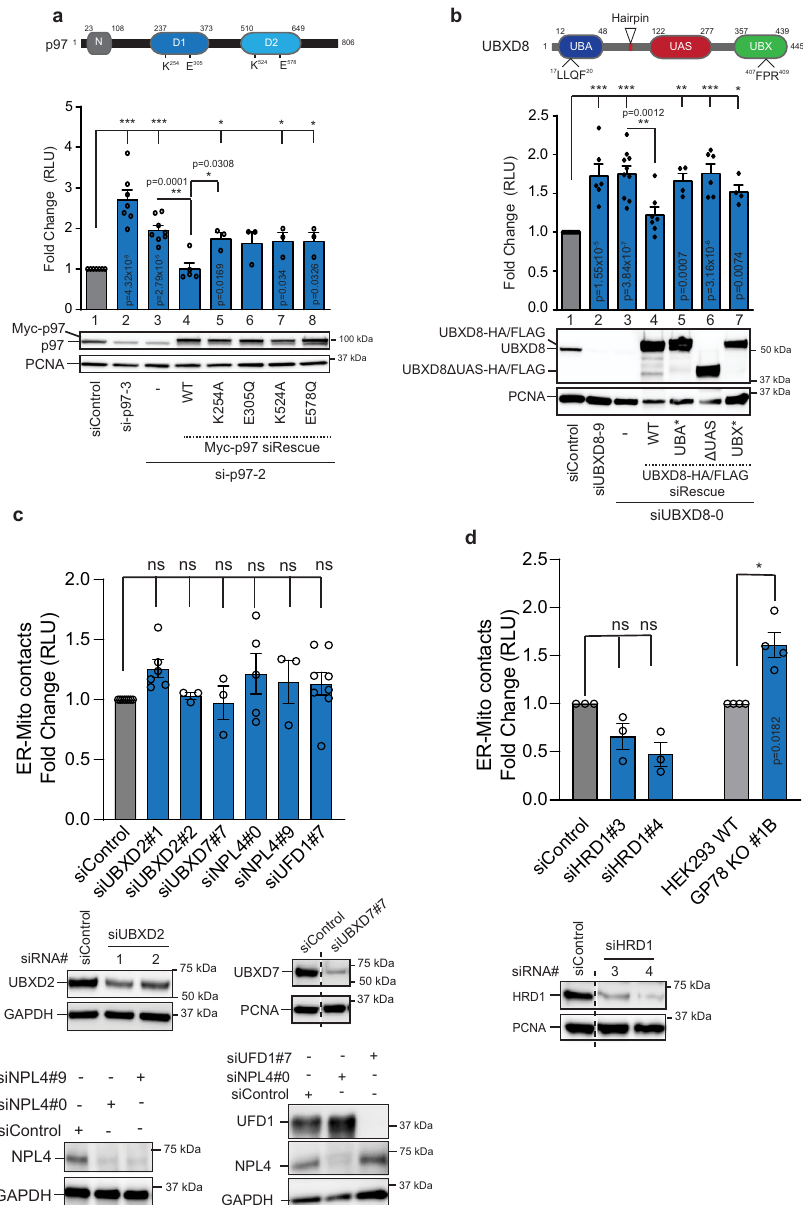
Fig. 2 | siRNA-mediated repression of p97 and UBXD8 results in increased ERMCS.a Top: Domain organization ofp97 and indicated mutations, Middle: Split luciferase assay to measure contacts in HEK293T cells transfected with siRNAs to p97 and indicated N-Myc siRNA-resistant rescue constructs, RLU relative lumines- cence unit, Bottom: Immunoblot of indicated proteins ( n =9, 7, 8, 5, 3, 3, 3, and 3 biologically independent samples from left to right, respectively). b Top: Domain organization of UBXD8 and indicated mutations, Middle: Split luciferase assay to measure contacts in HEK293T cells transfected with siRNAs to UBXD8 and indi- cated C-HA/FLAG siRNA-resistant rescue constructs, RLU relative luminescence unit, Bottom: Immunoblot of indicated proteins. UBA ubiquitin associated, UAS upstream activating sequence, UBX ubiquitin X. ( n =10, 6, 10, 7, 4, 6, & 4 biologi- cally independent samples from left to right, respectively). c Top: Split luciferase assay to measure contacts in HEK293T cells transfected with the indicated siRNAs